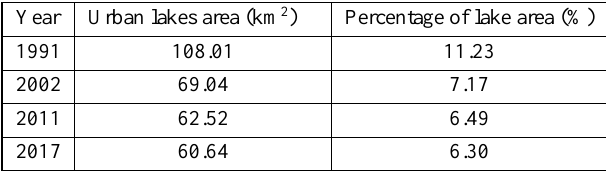
Table 2. Area statistics of Wuhan urban lakes over the